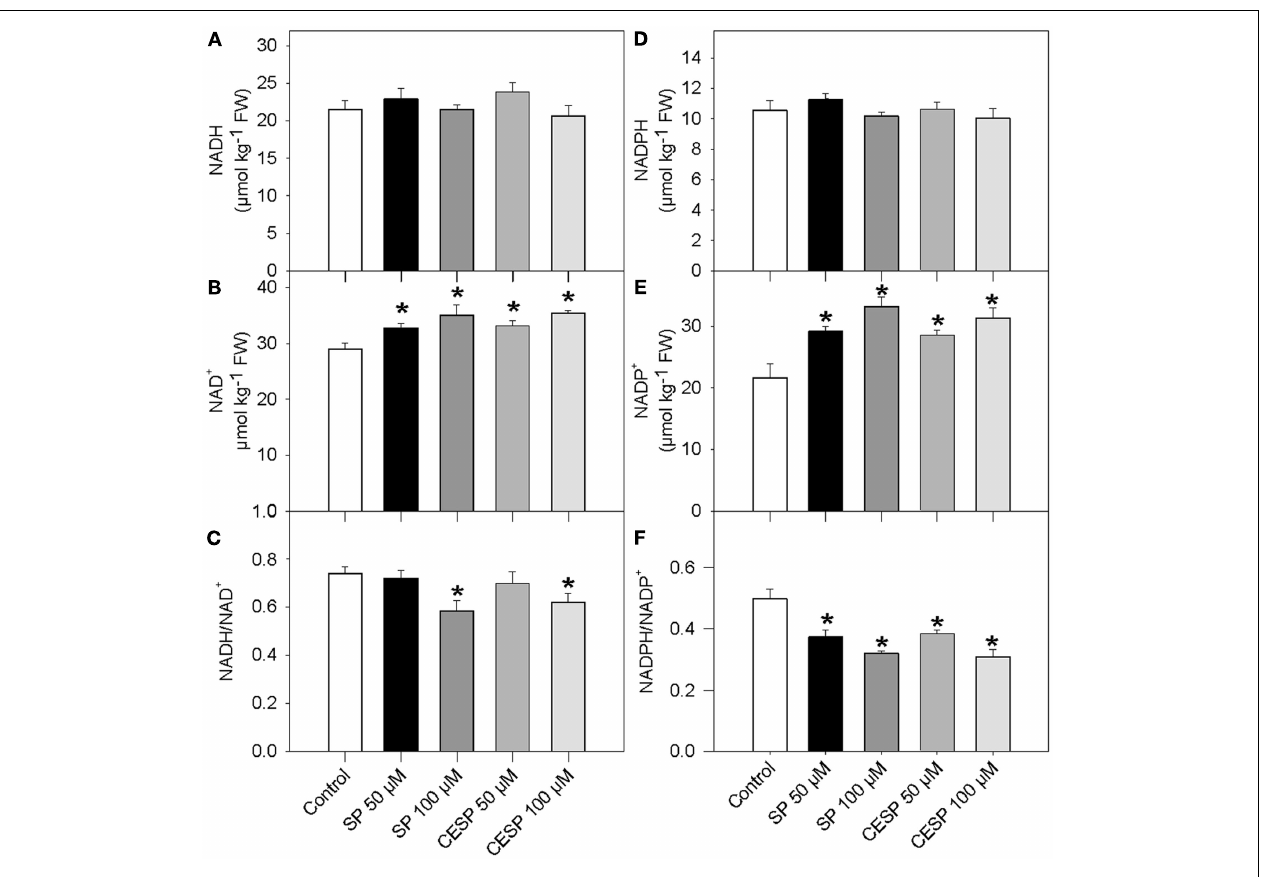
bars) levels of pyridine nucleotide [NADH (A) , NAD + (B) , NADPH (D) , and NADP + (E) ] and ratios [NADH/NAD + (C) and NADPH/NADP + (D) ] were measured.Values are means ± SE of six independent samplings. Asterisk indicates values that were determined by the Student’s t -test to be significantly different ( P < 0.05) from the control treatment. FW, fresh